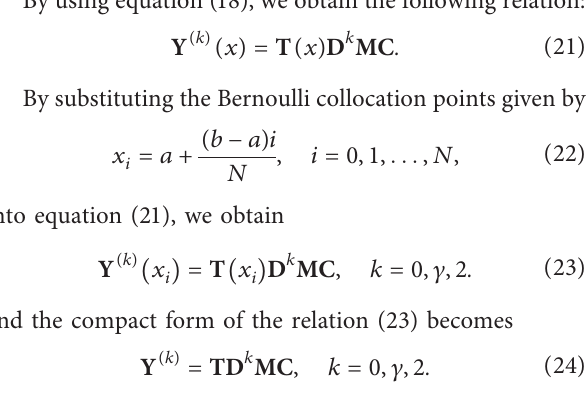
Table 3 for polybutadiene beam. The internal